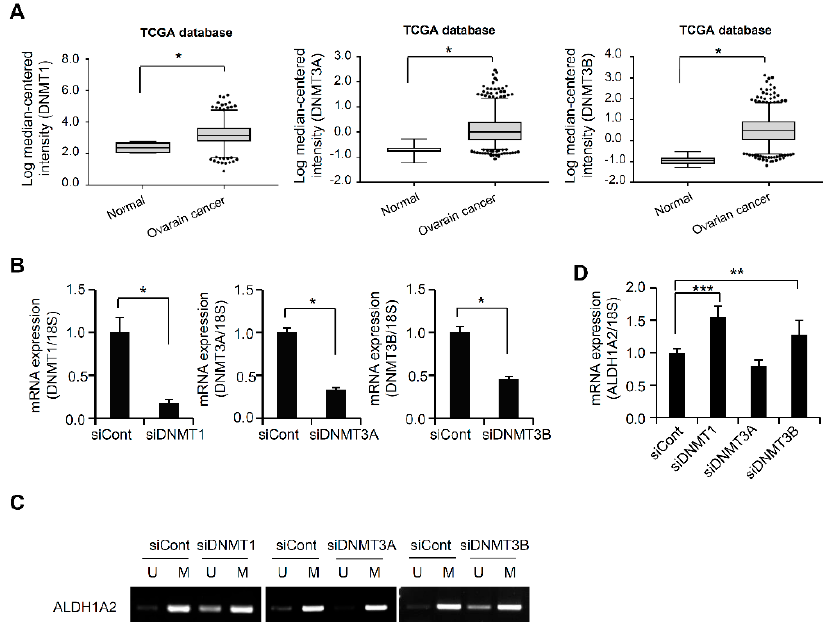
Figure 3. DNA methyltransferase (DNMT) is an upstream regulator of ALDH1A2 expression. ( A